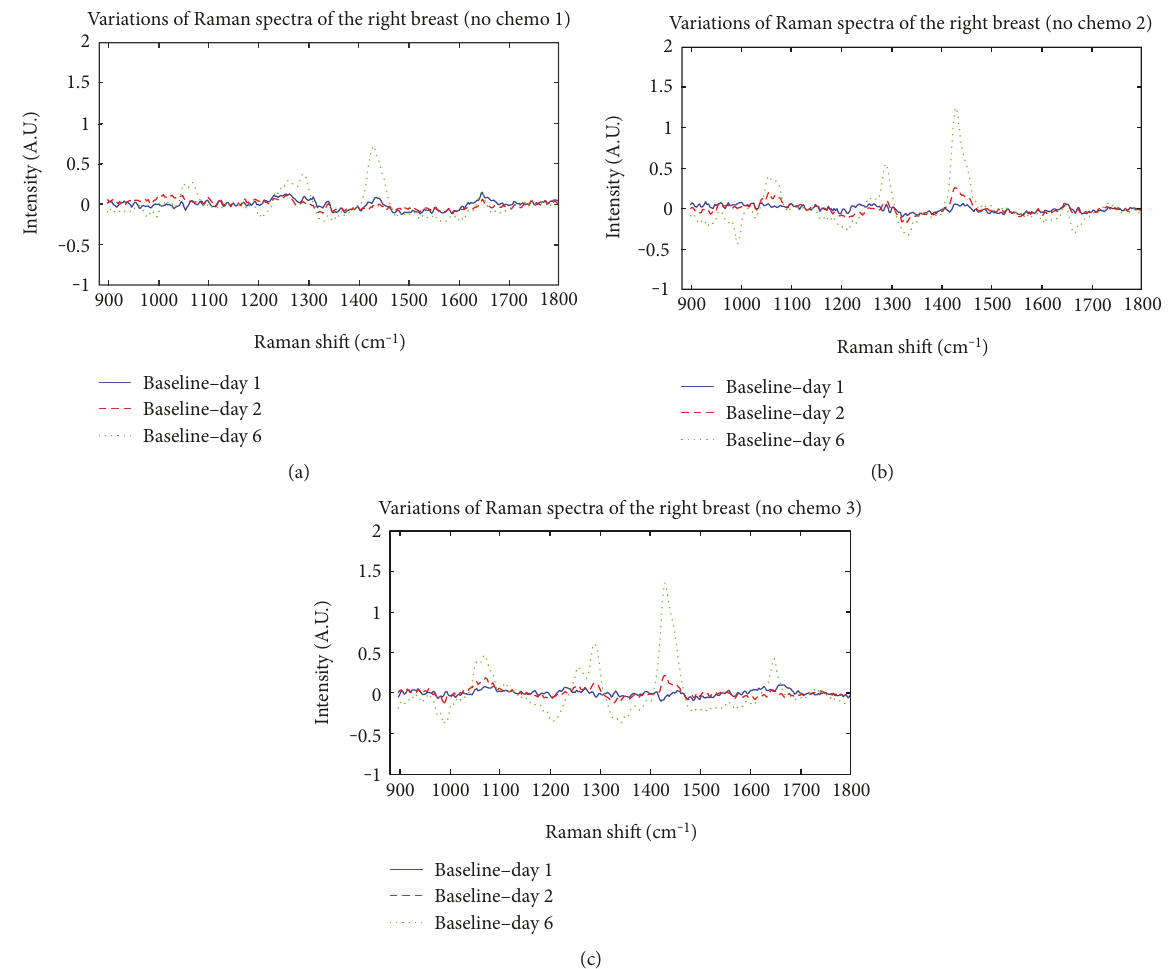
Figure 8: Variations of Raman spectra with regard to the baseline (no chemo group). The spectrum for each day was subtracted from the baseline signal. Positive values mean that the intensity was decreased, and the negative values mean that the intensity was increased with respect to the baseline signal. Day n means n day